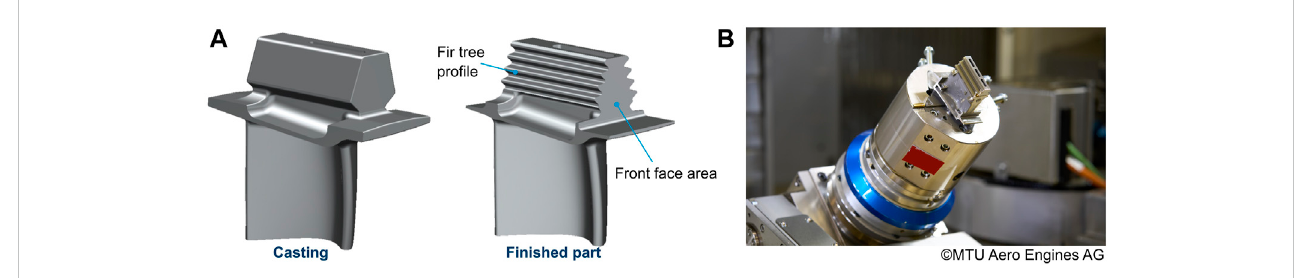
FIGURE 6 (A) Cast and fi nished part of an hpt blade with root pro fi le (courtesy of MAN Energy Solutions) (Grimmert and Wiederkehr, 2021a). (B) Clampedhpt blade for grinding in the FMS (copyright: MTU Aero Engines